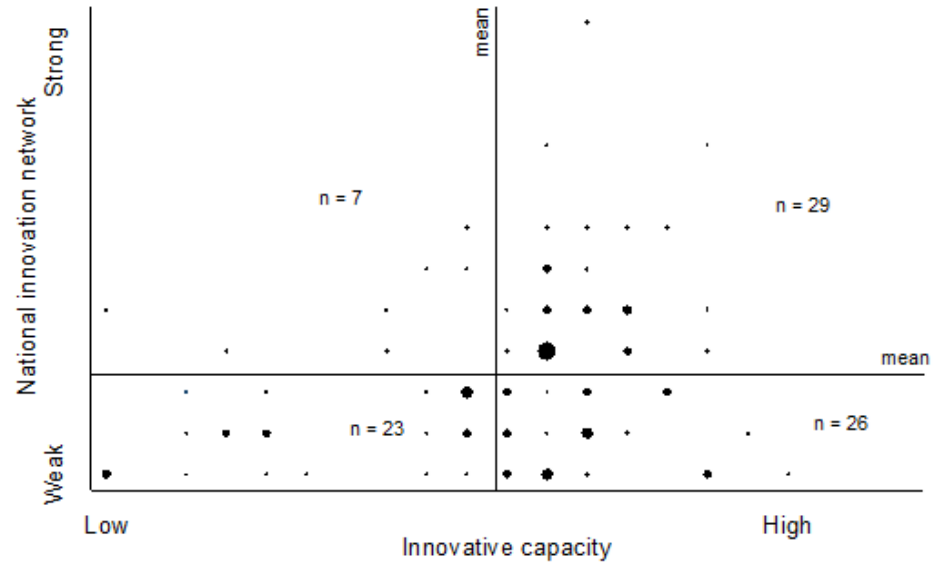
Figure 3: National Innovation Network and Innovation